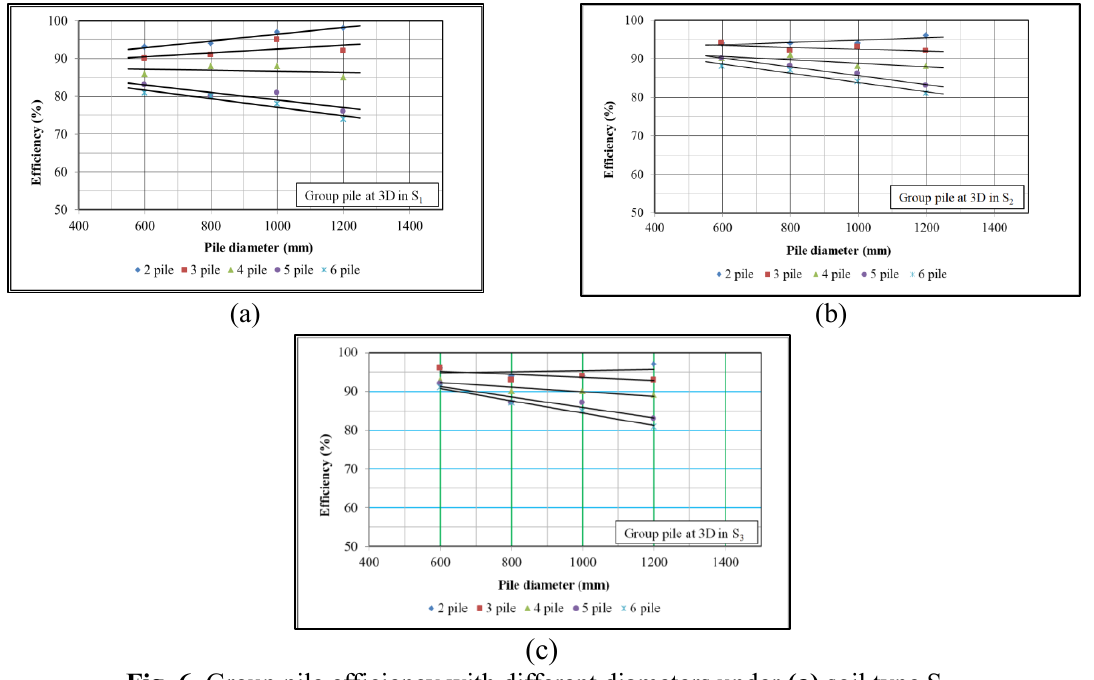
Fig. 6. Group pile efficiency with different diameters under (a) soil type S